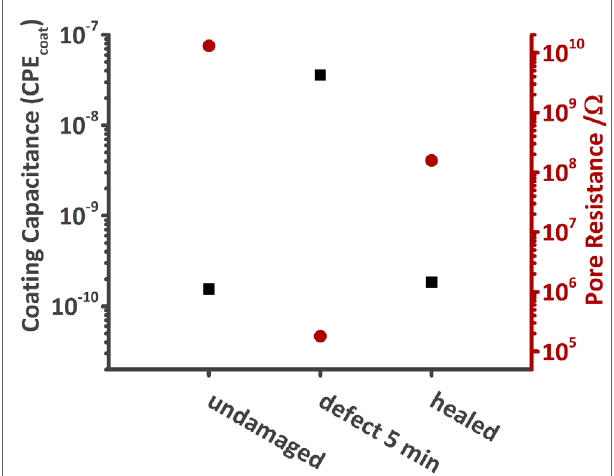
FigUre 11 | comparison of the coating capacitance and R pore of the undamaged, damaged, and healed Mash sample immersed in 0.05 M nacl solution . Both values recover after heating the MASH sample to